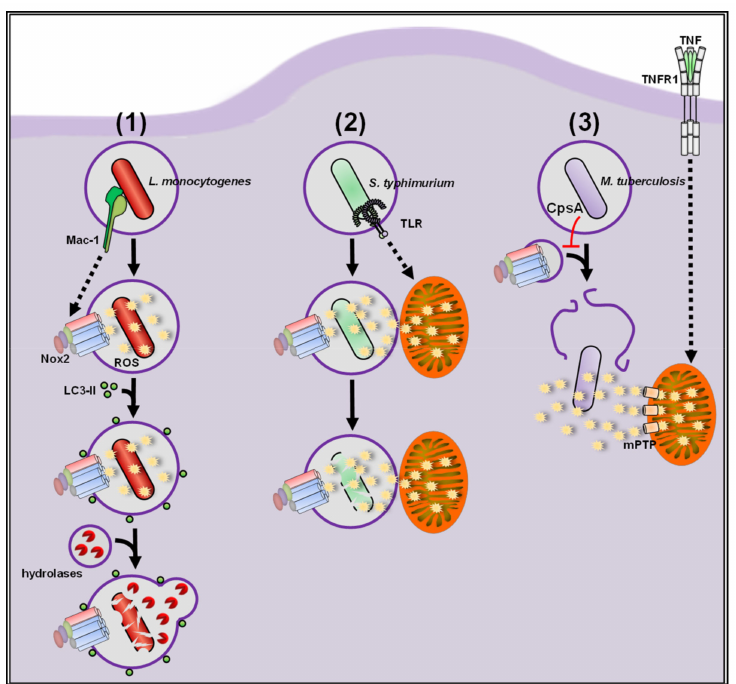
Figure 5. ( 1 ) During infection with L.m., tissue macrophages activate a highly antimicrobial phago- cytic pathway called LC3-associated phagocytosis (LAP). LAP induction strictly depends on produc- tion of extracellular ROS by Nox2, which induces the eponymous recruitment of LC3 to phagosomes. These so-called LAPosomes show enhanced fusion with lysosomes, leading to improved killing of L.m. by macrophages. ( 2 ) S.t. can evade degradation in the phagosome by using oxidative stress for their benefit. ROS production by Nox2 contributes to S.t. killing but, on its own, is not sufficient for complete eradication of the pathogen. Mitochondria are recruited as additional ROS source via Toll-like receptor (TLR) signaling to overcome the antioxidative capacity of S.t. resulting in its degra- dation. ( 3 ) Mtb inhibits Nox2-mediated ROS production and subsequent LAP induction through its virulence factor CpsA and quickly escapes into the cytosol. Macrophages activate excessive production and release of mtROS through the mitochondrial permeability transition pore (mPTP) via TNF receptor 1 (TNFR1) signaling to combat cytosolic